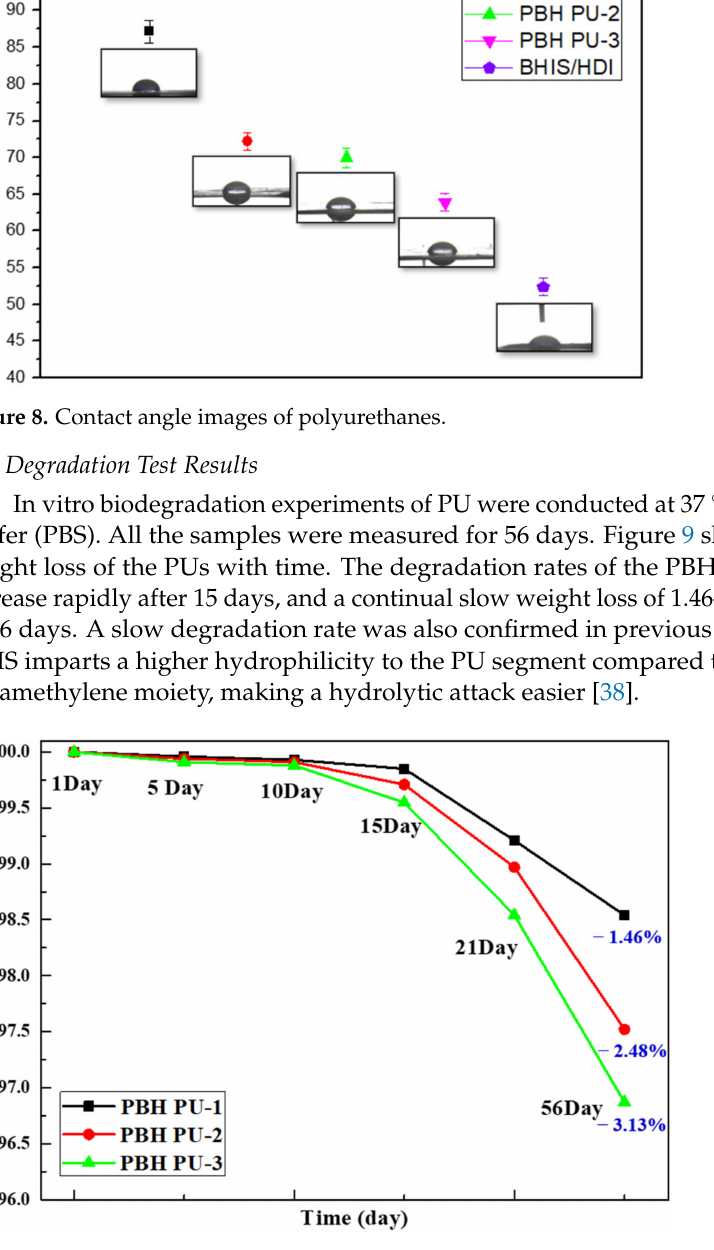
Figure 9. Degradation test data of polyurethane